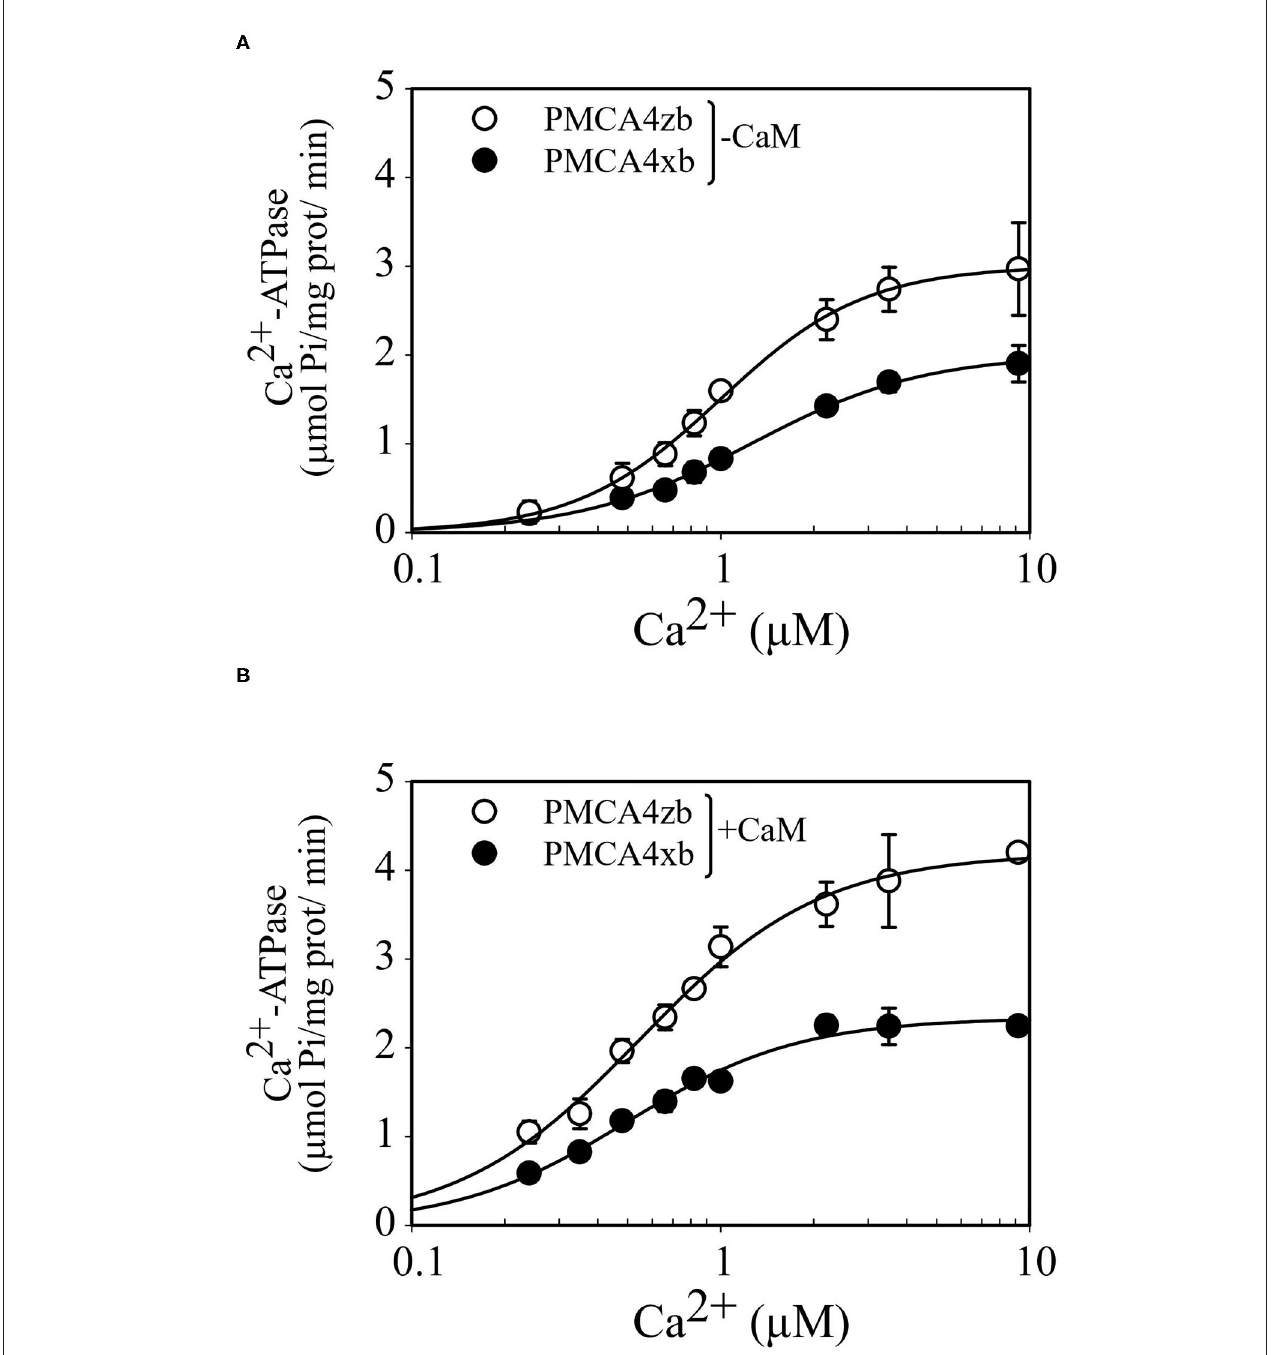
FIGURE 5 | Ca 2 + dependence of the Ca 2 + -ATPase activity of purified PMCA4zb-GFP and PMCA4xb-GFP in the absence (A) and the presence of calmodulin (B) . The ATPase reaction was measured at 28 ◦ C as described previously (Mazzitelli and Adamo, 2014). The reaction media contained 1 µ g of PMCA supplemented with PC, 50mM HEPES-K (pH = 7.2 at 28 ◦ C), 100mM KCl, 4mM MgCl 2 , 3mM ATP, 500 µ M EGTA, and enough CaCl 2 to give the indicated concentrations of Ca 2 + . When calmodulin was present its final concentration was 200nM. The reaction time was 15min. The data points are from a representative experiment conducted in duplicate. Error bars show the SD. The lines are the best fit to the data given by the Hill equation v = Vmax *[Ca] nH /([K 0.5Ca ] nH + [Ca] nH ) using the values of the parameters shown in Table 1 .